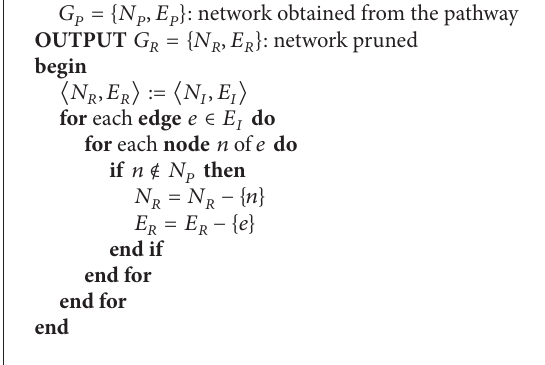
Algorithm 1: Pruning